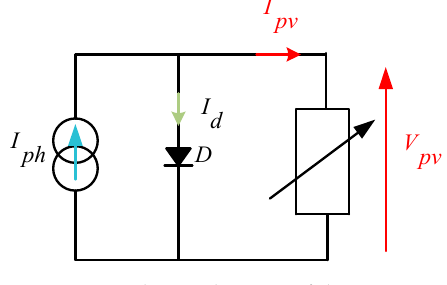
Figure 3. Electrical circuit of the ISDM.